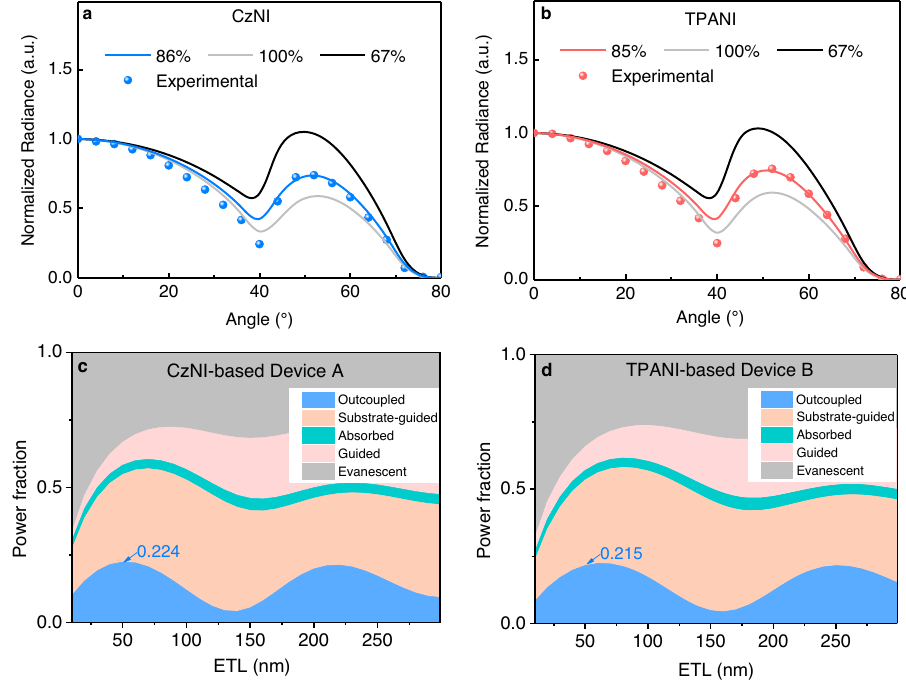
Fig. 3 | Horizontal dipole measurements together with optical simulation. p -Polarized angle-dependent PL radiance of neat fi lm samples of a CzNI and b TPANI. Simulated photon distributions of all loss channels as a function of the